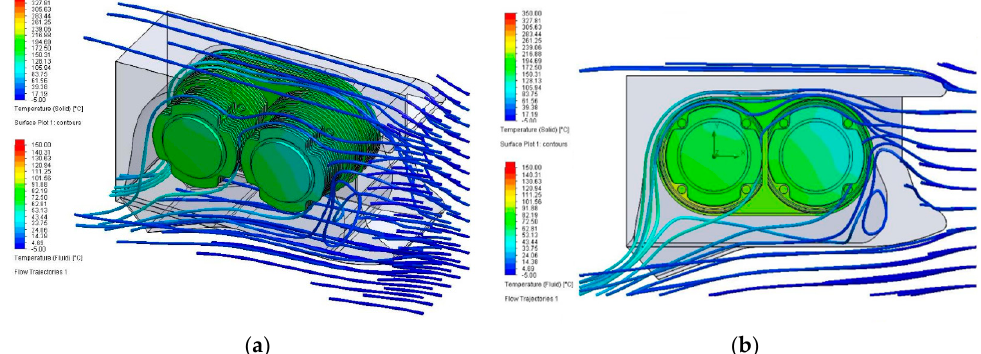
Figure 5. Simulation result from initial temperature of 180 °C at 80 kt: ( a ) Isometric view ( b ) Side